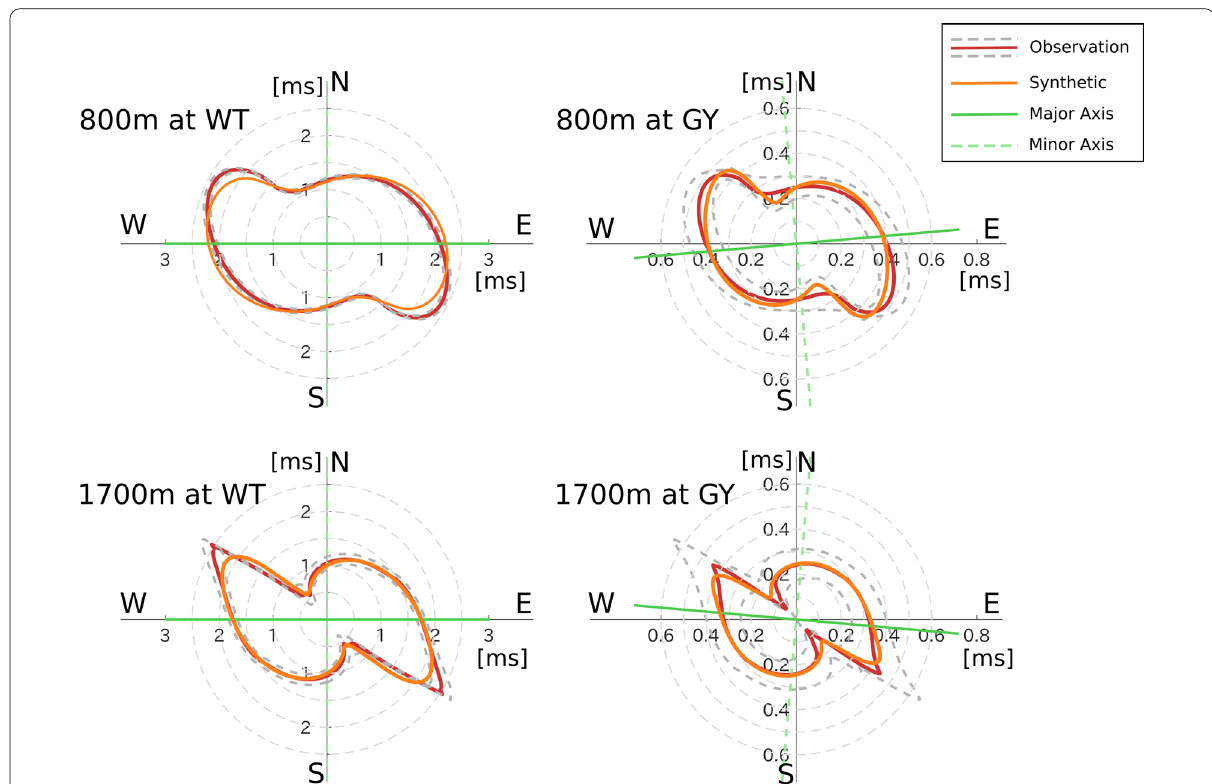
Fig. 11 Principal axes of the coseismic delay estimated with the parameter estimation. The red line shows the observed pattern. The orange line shows the synthetic pattern with the best parameter. Solid and dashed green lines show the major and minor axes of the principal axes, respectively. The top and bottom panels show the results for the 800-m and 1700-m sensors. The left and right panels show the results for the WT and GY earthquakes,